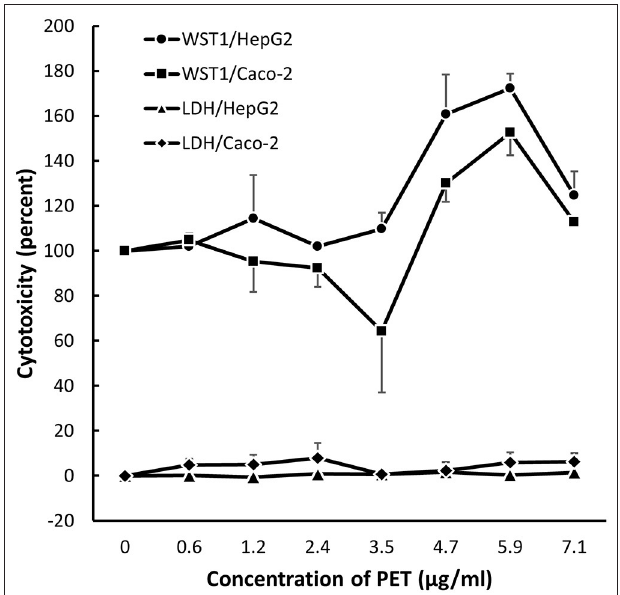
FIGURE 6 | Metabolic activity (WST-1 assay) and cell membrane leakage (LDH assay) after 24h exposure to nanoplastics from black PET food containers (main study). The results are mean and SEM from three independent experiments.